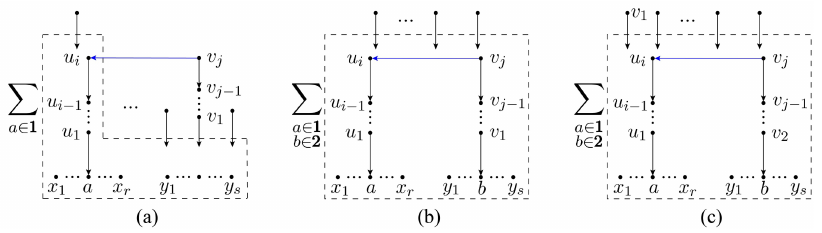
Figure 7 . The typical graph (a) in category-1 can only be obtained from spanning forests (b) and